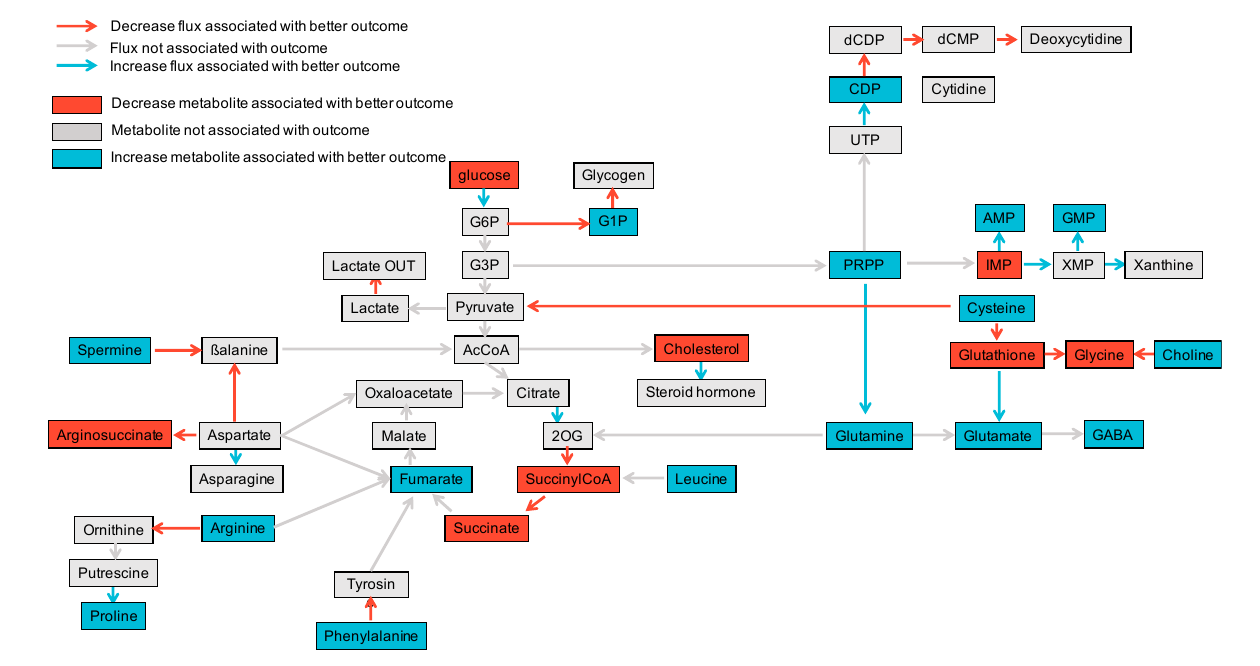
Figure 2. Comprehensive map linking estimation of fluxome and metabolites’ abundance with one- year eGFR. In blue are any positive associations between the metabolites’ estimated abundance or estimated reaction flux with one-year eGFR while in red are negative associations. Non-significant associations are shown in grey.